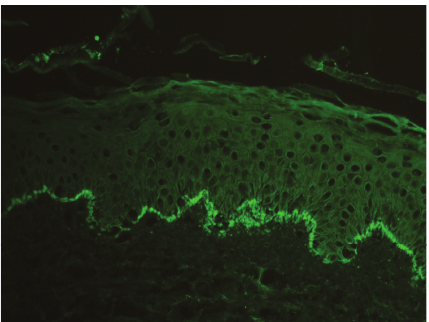
Figure 3: Direct immunofluorescence photomicrograph showing linear band of complement C3 deposition along the basement membrane zone ( ×